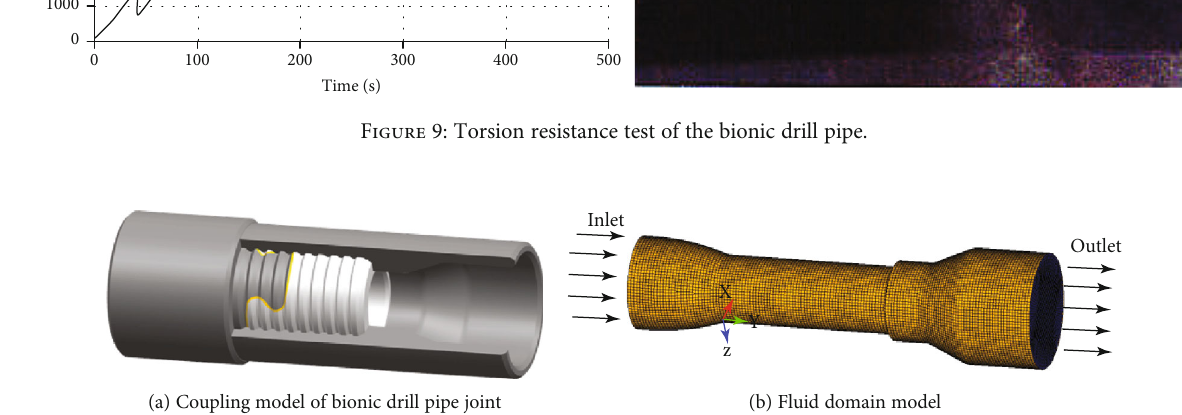
Figure 10: Bionic drill pipe joint model and fl uid domain